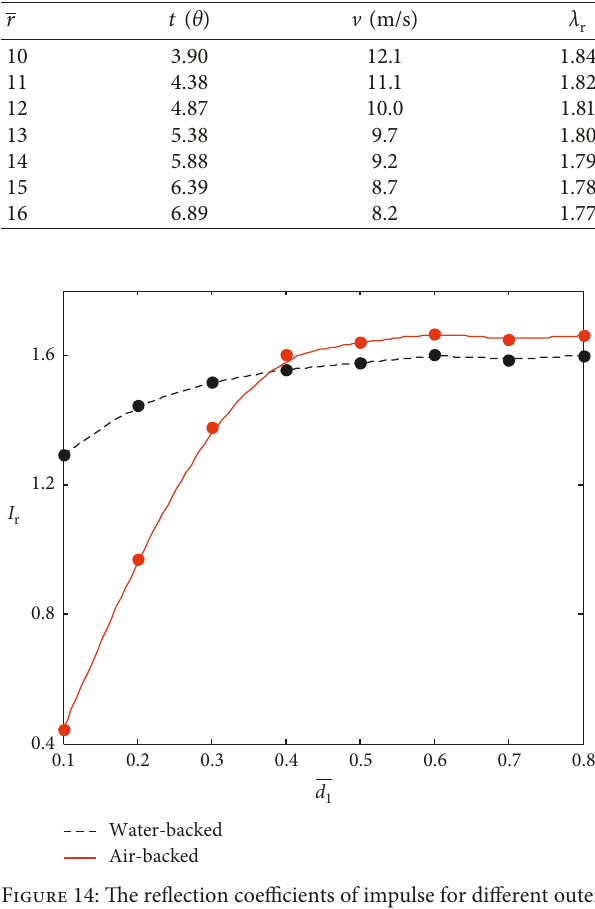
Figure 14: The reflection coefficients of impulse for different outer shell thicknesses.